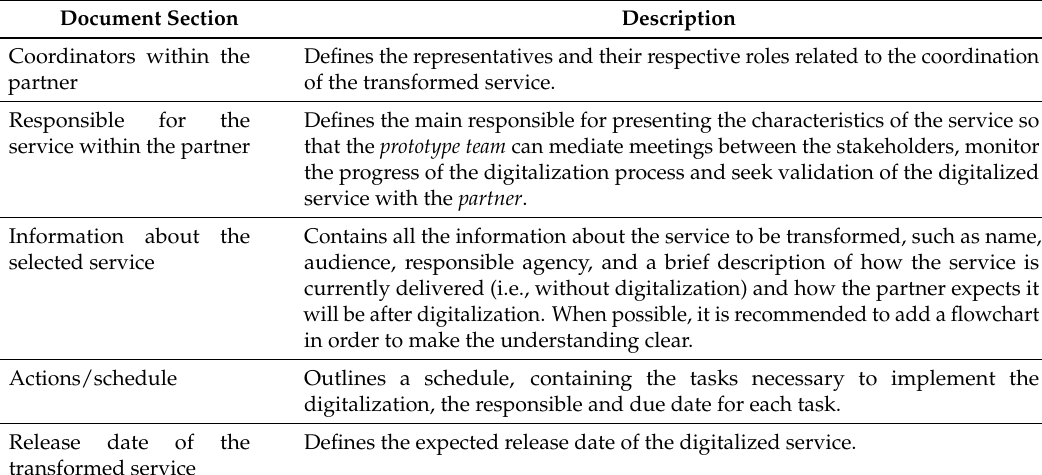
Table 1. Integration plan template.